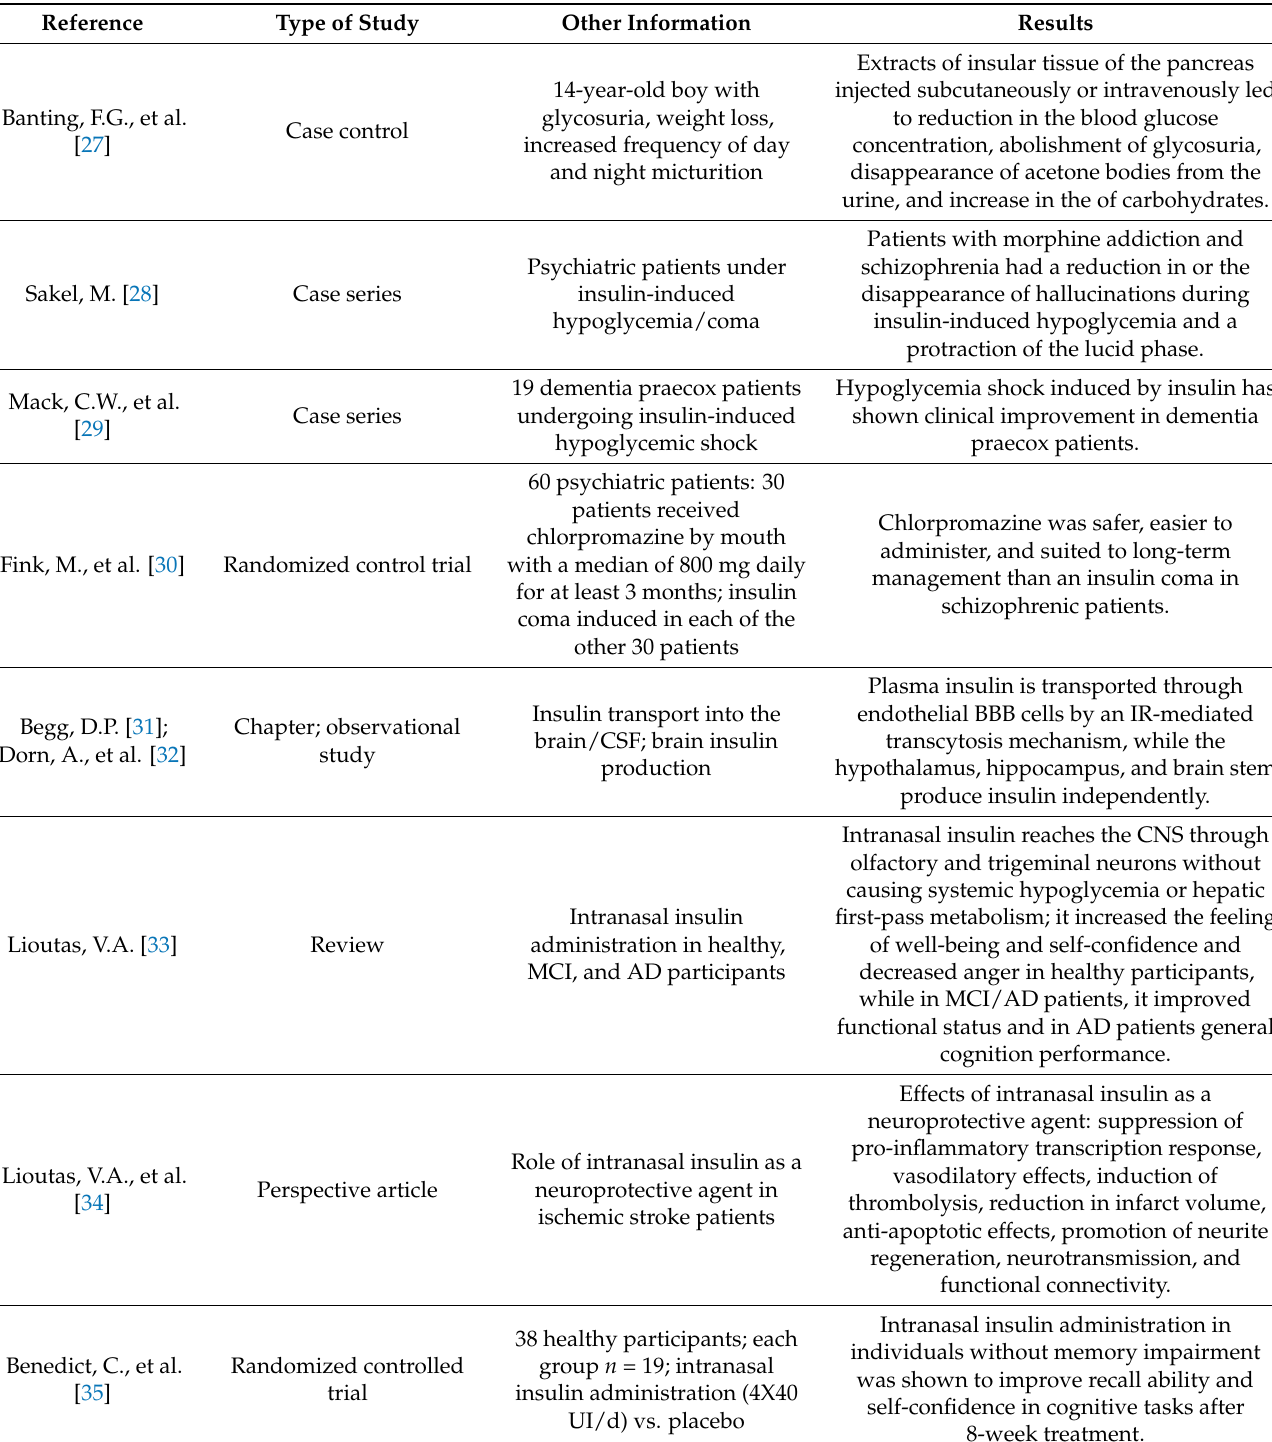
Table 2. Clinical evidence: systemic, neurocognitive, and neuromolecular changes after insulin